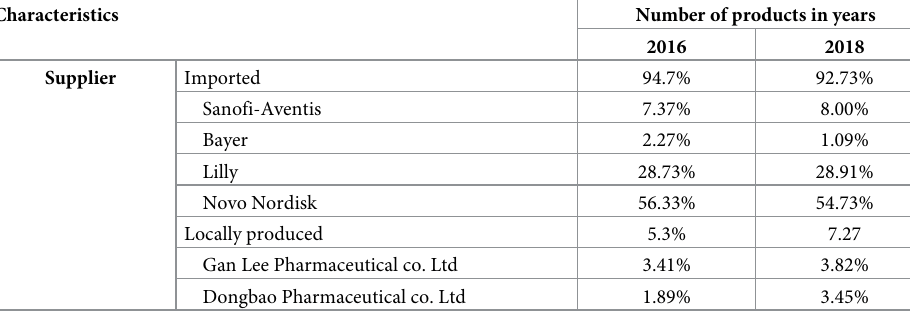
Table 5. Suppliers of insulin products found in the